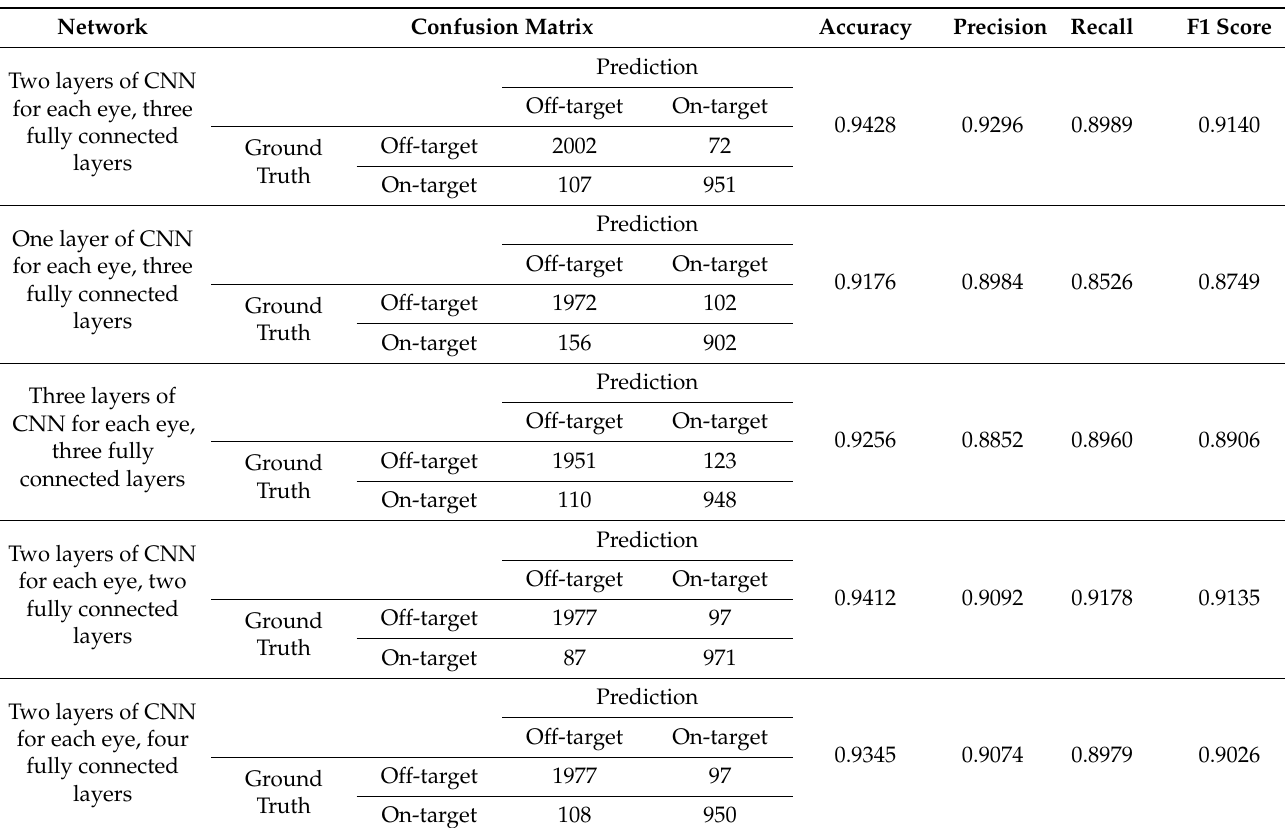
Table 2. Comparison of different neural network